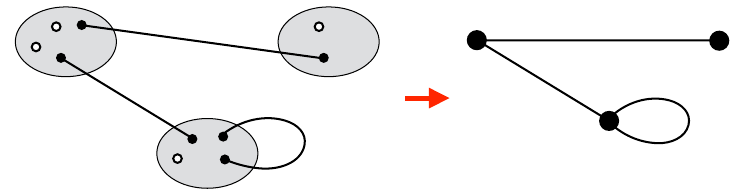
Figure 6. Left: a contraction of three vertices, n = 3 in (B.1). The generated H eff term has l = 4 (the total number of empty circles). Right: the graph of contractions obtained when every gray oval is shrunk to a point (denoted by a fat dot). This graph is connected, as it should be because we are considering connected